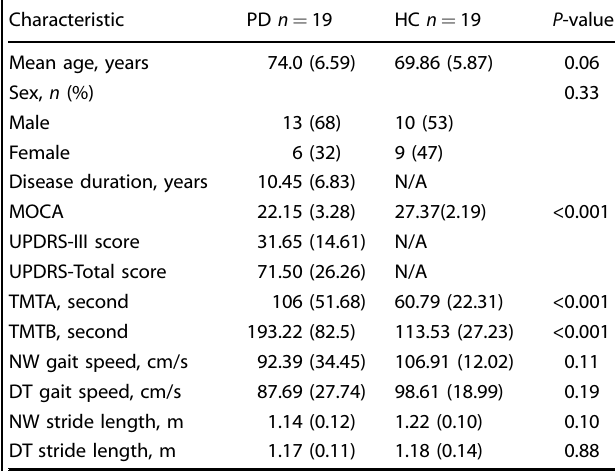
Fig. 1 Methodology pipeline. a PD patients underwent 6 weeks of treadmill training. b T1/fMRI acquisition during resting state before and after the training. c fNIRS acquisition during normal and dual-task walking tasks. d EC analysis with TPDC for fMRI. e EC analysis with TPDC for fNIRS. f SVM classi fi cation based on rs-fMRI connectivity as the predictors. g SVM regression based on rs-fMRI connectivity to predict fNIRS connectivity. h All the feature combinations pass through nested cross validation. i Select the optimal SVM model based on the model performance. PD Parkinson ’ s disease, fNIRS functional near infrared spectroscopy, EC effective connectivity, fMRI functional magnetic resonance imaging, SVM support vector machine, TPDC time resolved partial directed coherence. Table 1. Demographics and disease characteristics at